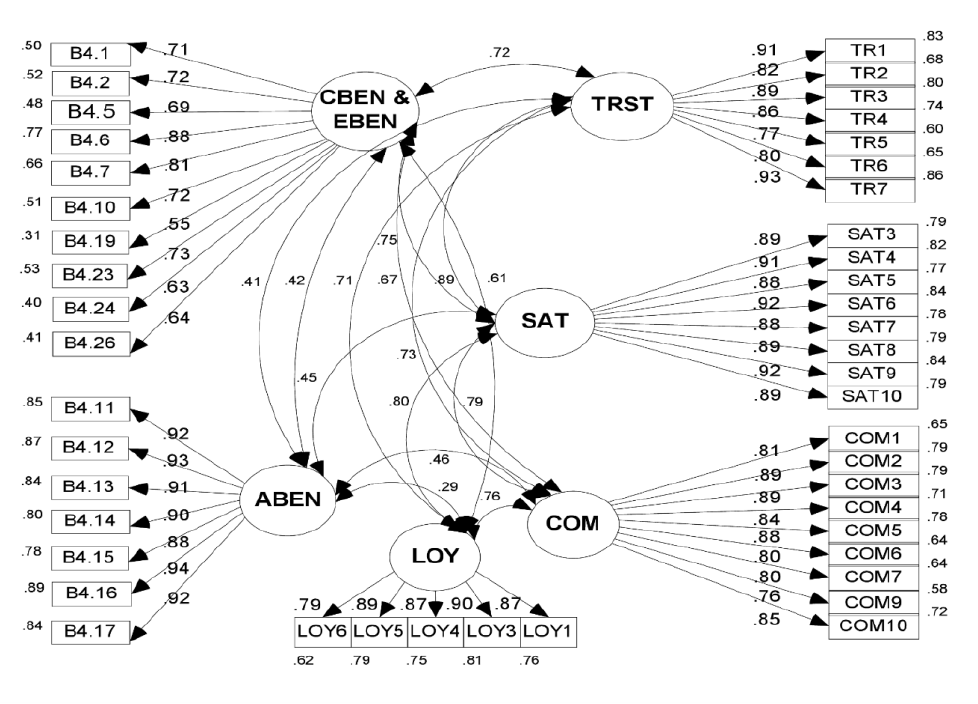
Figure 2: Modified Measurement Model; Source : Authors